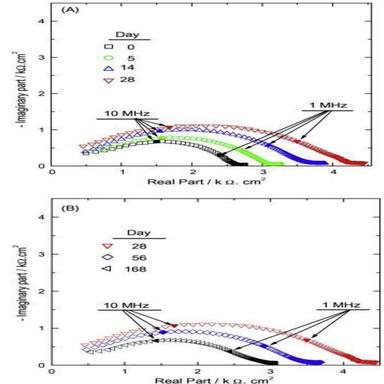
Nyquist impedance plots for mortar sample saturated with NaCl 1 mol/L solution. (A) Evolution from day 0 to day 28 and (B) evolution from day 28 to the end of the experiment.